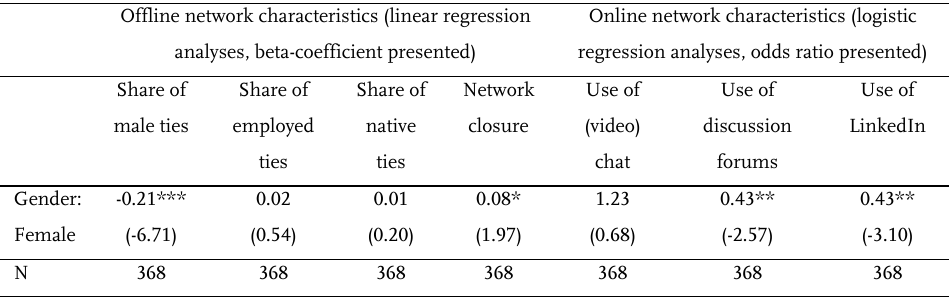
Table 3 : Impact of gender on network characteristics Offline network characteristics (linear regression